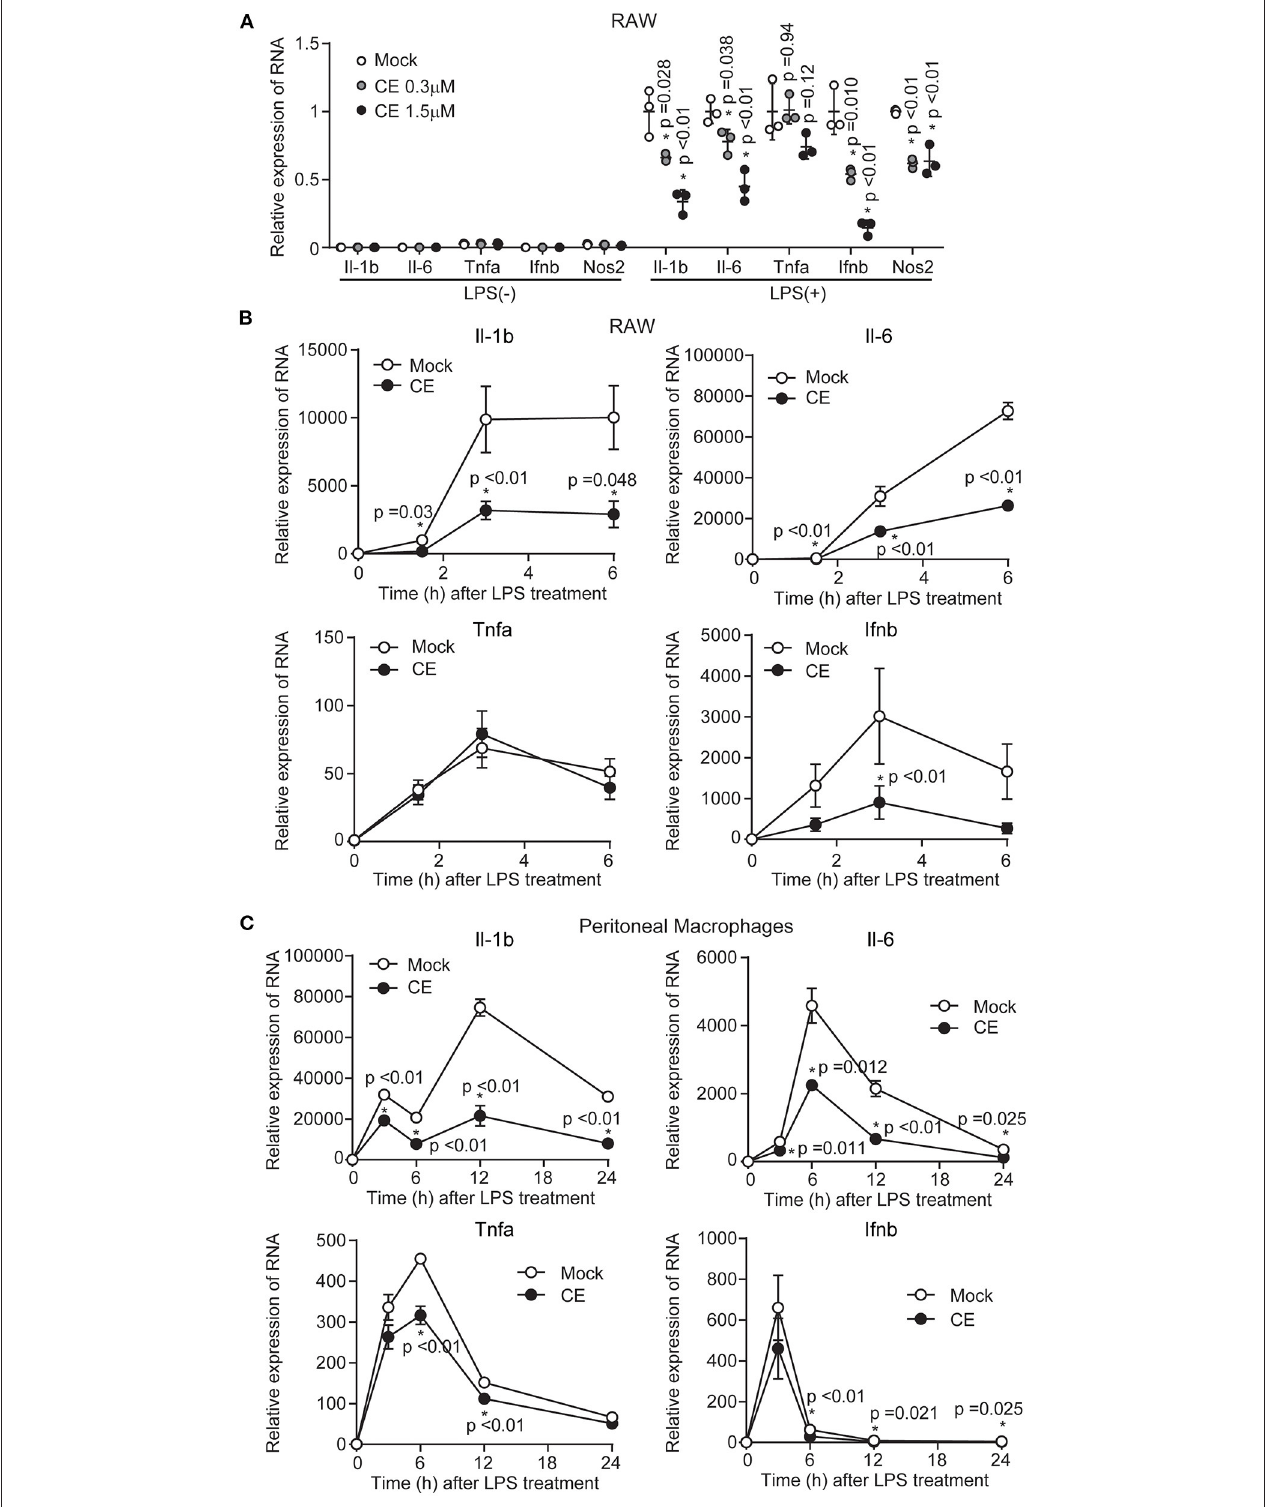
FIGURE 1 | The effect of Chlorella extract on the expression of inflammatory genes in LPS-stimulated murine macrophages. (A) RAW264 cells were treated with Mock or CE for 16h before being stimulated with LPS (100ng/mL) for 3h. The mRNA levels of Il-1b, Il-6, Tnfa, Ifnb1, and Nos2 of expressions were analyzed. (B,C) RAW264 cells and pMACs were treated with Mock or CE for 16h before being stimulated with LPS (100ng/mL) for the indicated time periods. The mRNA levels of Il-1b, Il-6, Tnfa and Ifnb1 of expressions were analyzed. All data were normalized expression of the gene encoding 18S ribosomal RNA (18S rRNA). Error bar show mean ± SEM. * p < 0.05 vs. Mock-treated groups. Data are representative of three independent experiments.